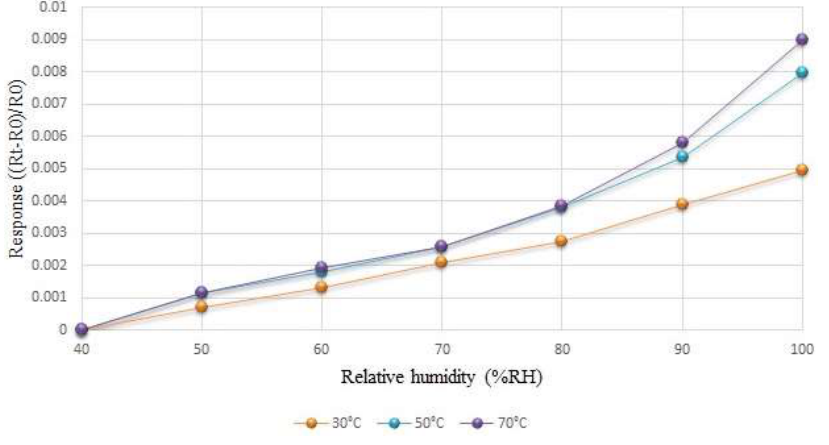
Figure 7. The average calibration curve of the humidity microsensor at different temperatures.